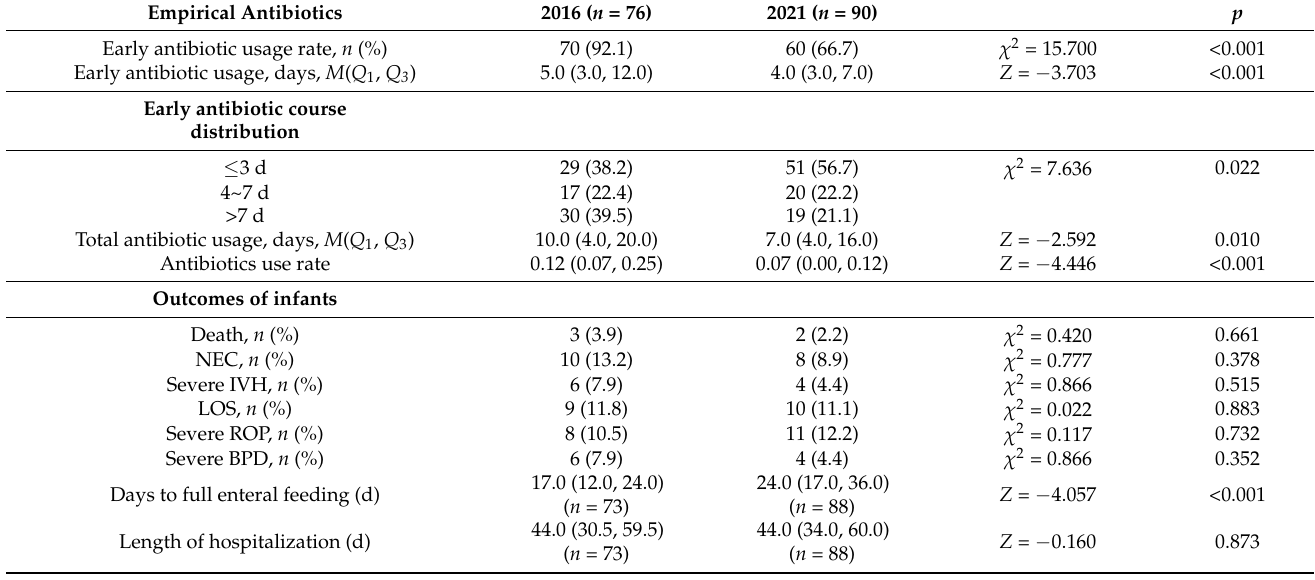
Table 5. Postnatal empirical antibiotic usage and short-term outcomes between the 2016 and 2021